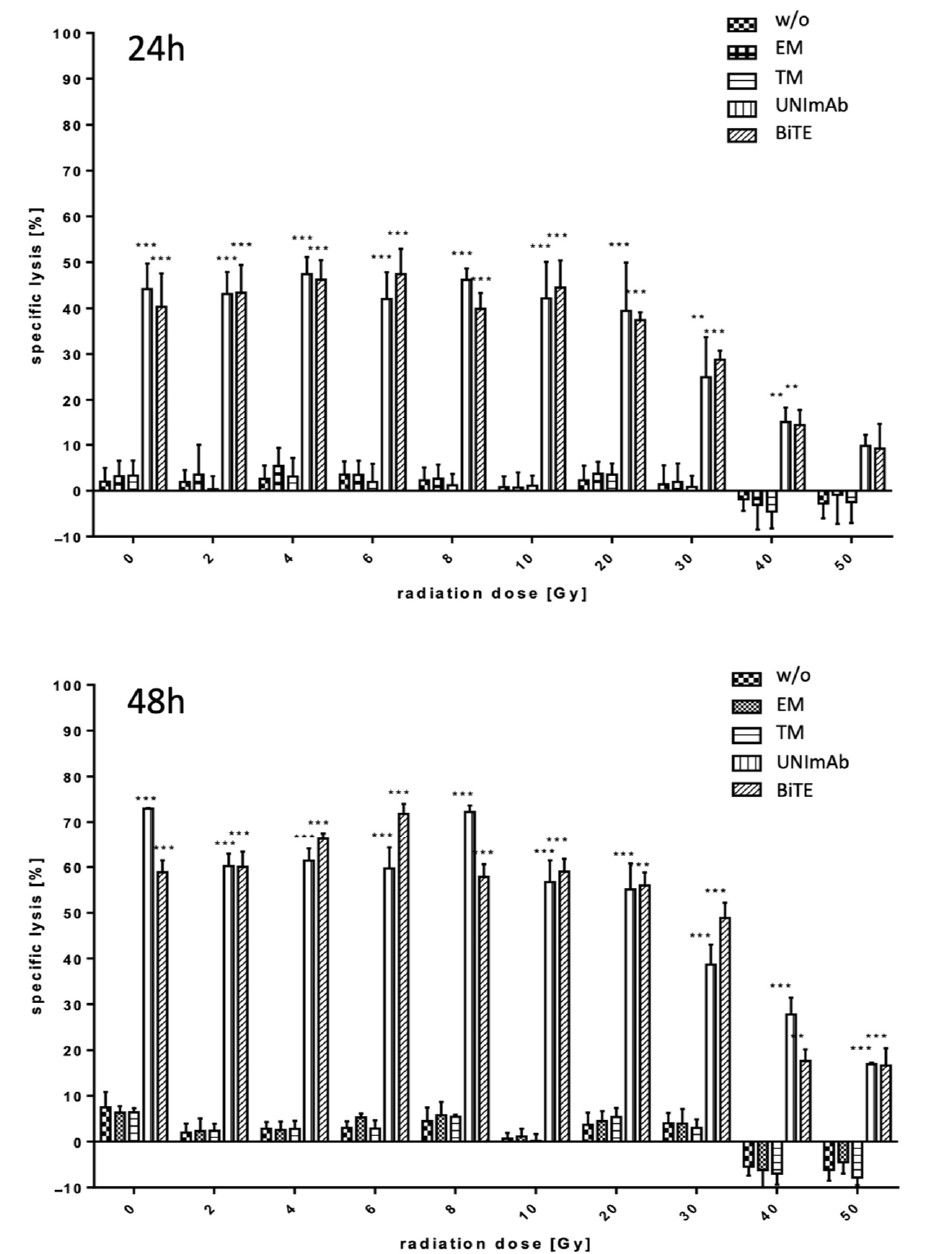
Figure 2. Retargeting of tumor cells with irradiated T cells. Estimation of lysis capability. Pan T cells were redirected either in the absence (w/o) or presence of 30 pmol/mL of the respective Ab components (effector module alone (EM), target module alone (TM), UNImAb complex (UNImAb), conventional BiTE (BiTE)). Both, the CD3-PSCA bsAb (BiTE) or the UNImAb format were able to efficiently lyse the PSCA-positive tumor cells even after radiation with up to 50 Gy (** p < 0.01 and *** p < 0.001 in relation to the controls (without Ab (w/o), the effector module (EM) or the target module (TM) alone). The data shown were collected for three individual donors. (one-way ANOVA, Bonferroni Multiple Comparison